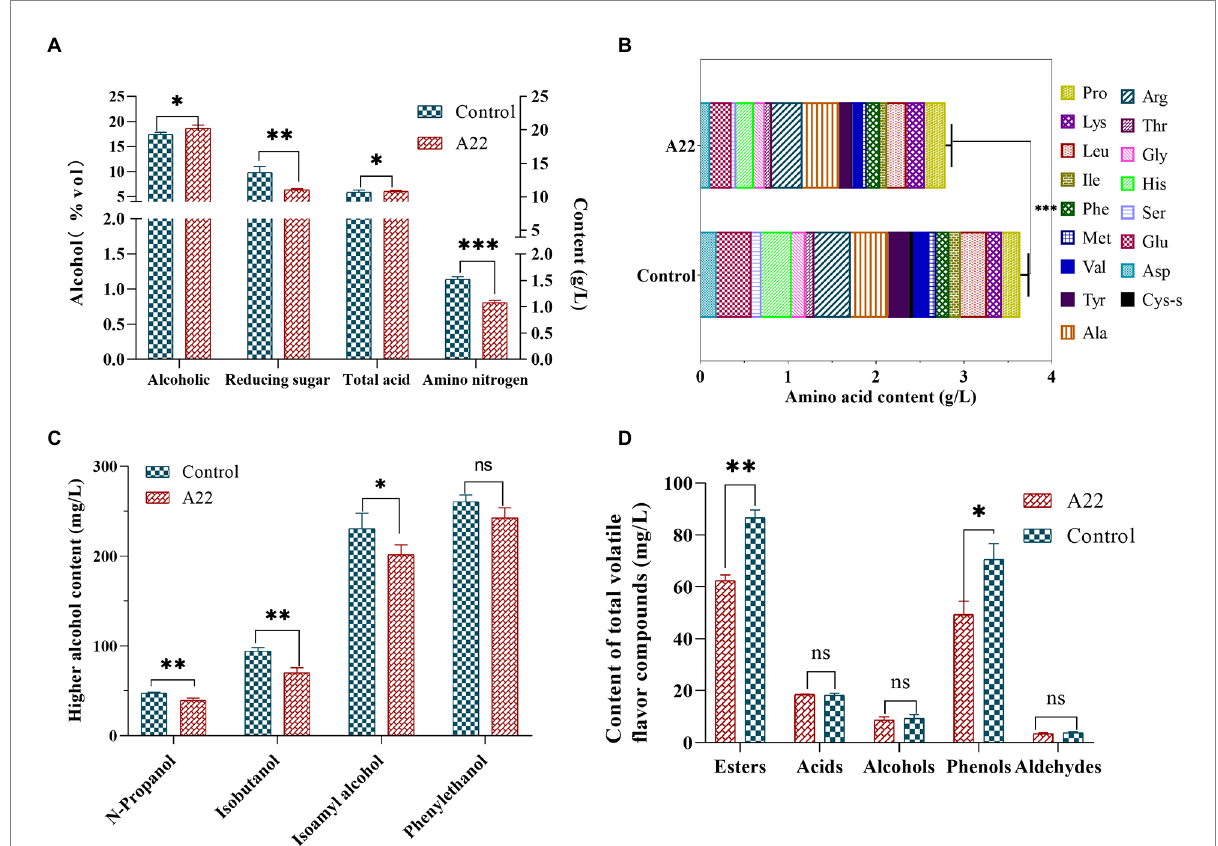
FIGURE 6 Physicochemical indexes (A) , content of free amino acid (B) , higher alcohol (C), and total flavor substance (D) of huangjiu . ns, not significant; * p < 0.05 (moderately significant); ** p < 0.01 (significant); and *** p < 0.001 (highly significant).